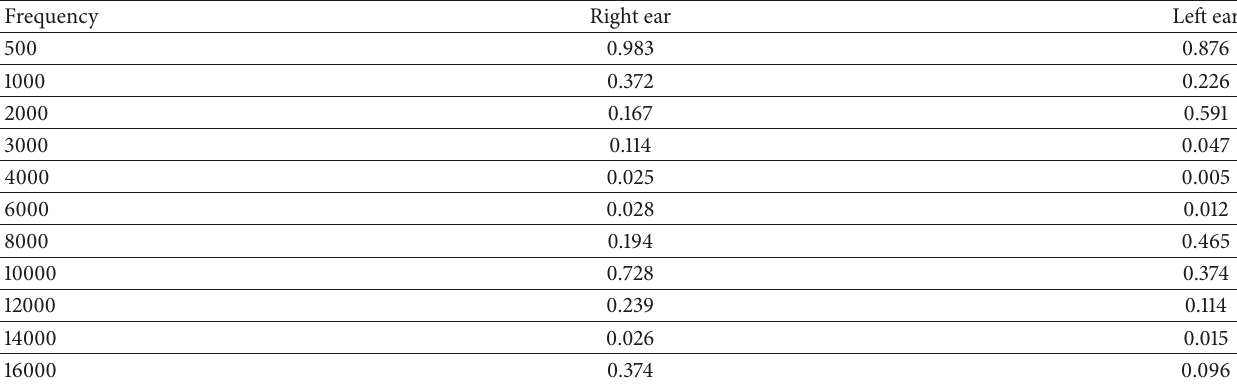
Table 2: P value of the comparison of mean hearing thresholds at three occasions (baseline, 1 hour, and 24 hours after MRI). Frequency Right ear Left ear